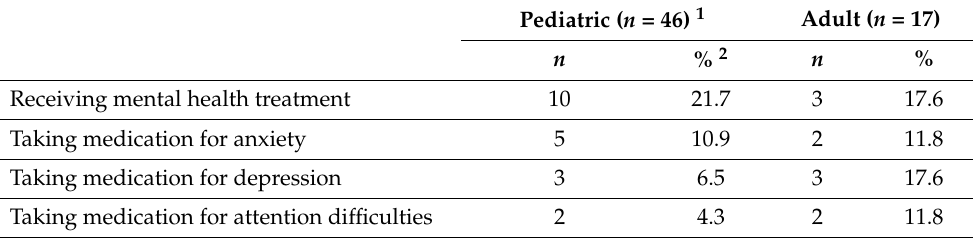
Table 3. Mental health treatment